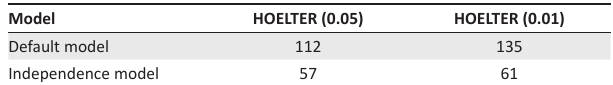
TABLE 6f: SEM model fit statistics.